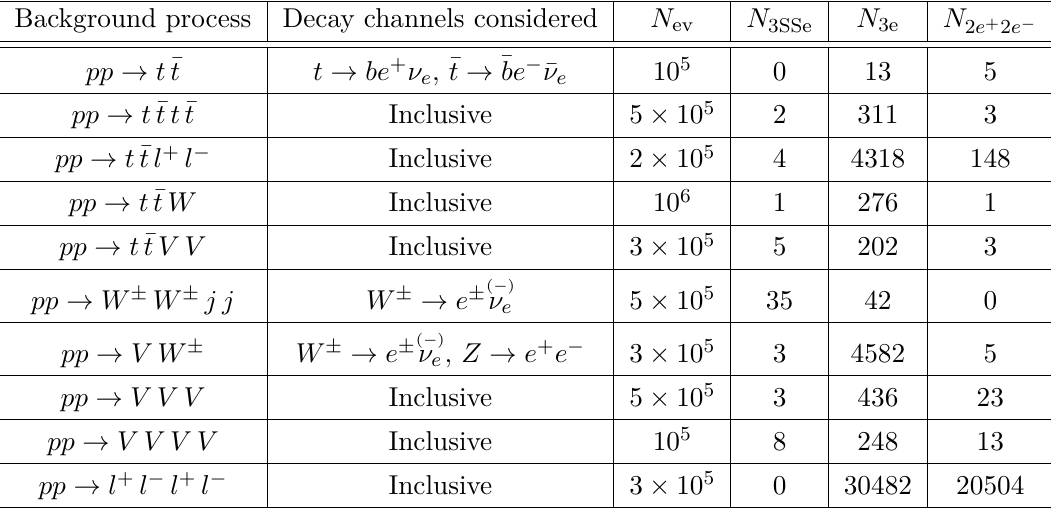
Table 4 . For each SM background process of the first column, we generate N ev events. We obtain N 3SSe events with final states containing three same-sign electrons, N 3e events with final states containing three electrons, not all of the same sign, and N events with final states containing 2 e + 2 e − two e + e − pairs. The second column indicates whether the produced state f of the first column decays to a specific final state or to all possible final states (inclusive).